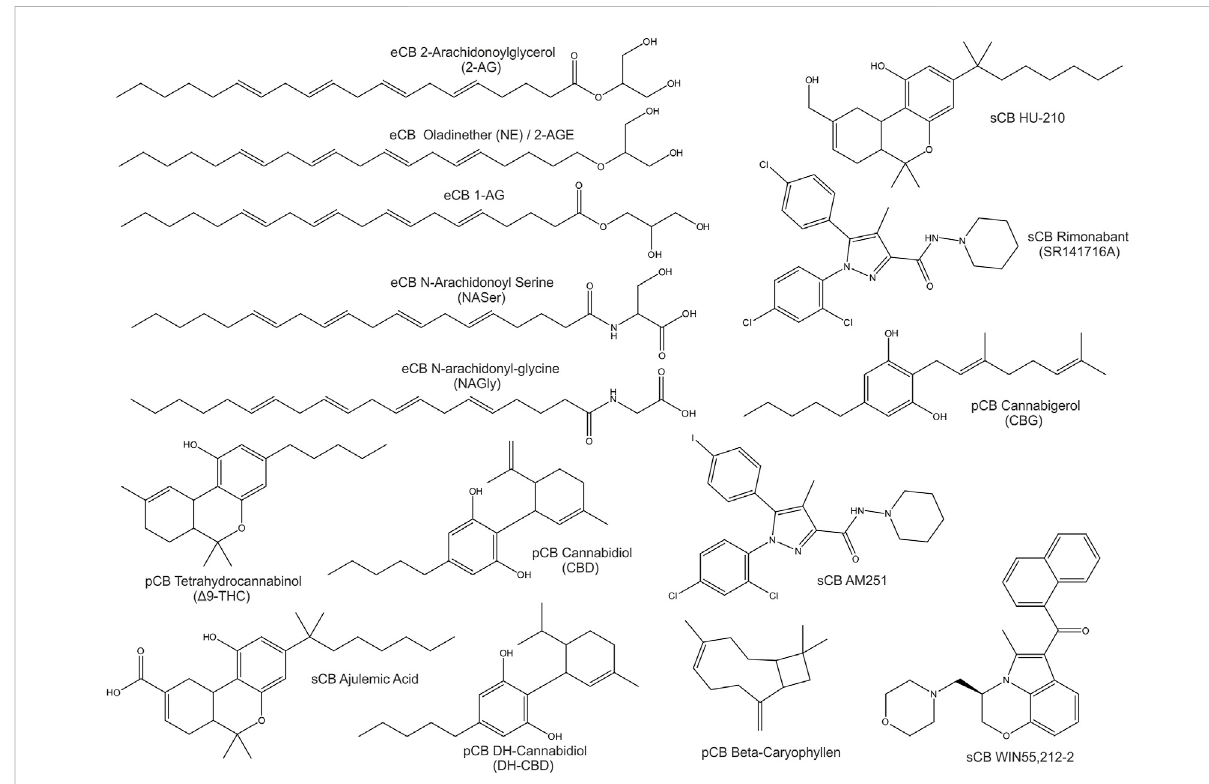
FIGURE 1 2D-Structures of selected cannabinoids: endogenous cannabinoids (eCB), phytocannabinoids (pCB) and synthetic cannabinoids